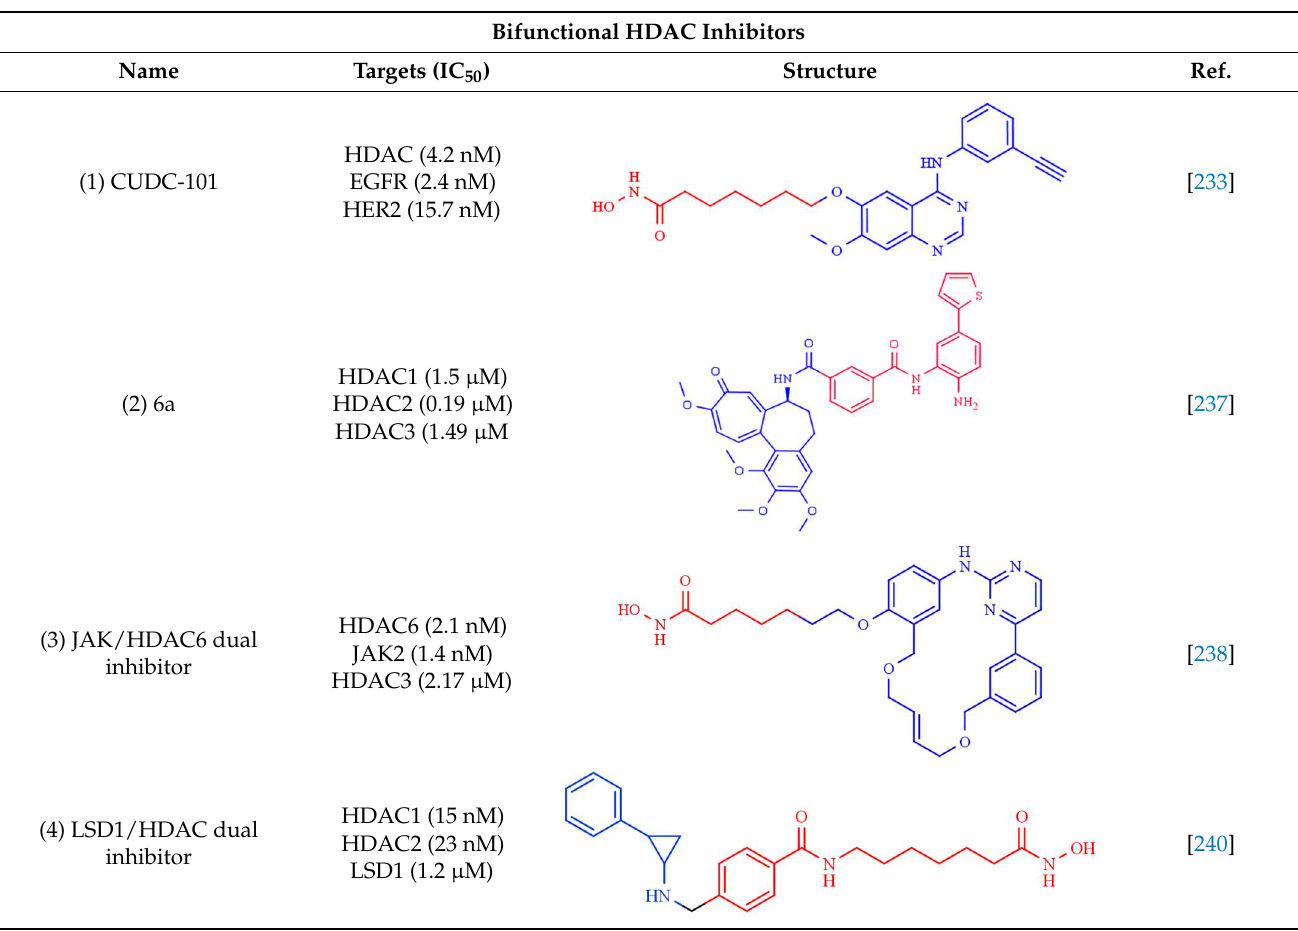
Table 4. Selected bifunctional HDAC inhibitors. Red shows HDAC pharmacophoric features, and blue represents receptor tyrosine kinase inhibitor (1), colchicine (2), JAK2 inhibitor (3), and lysine- specific demethylase 1 (LSD1) inhibitor (4).